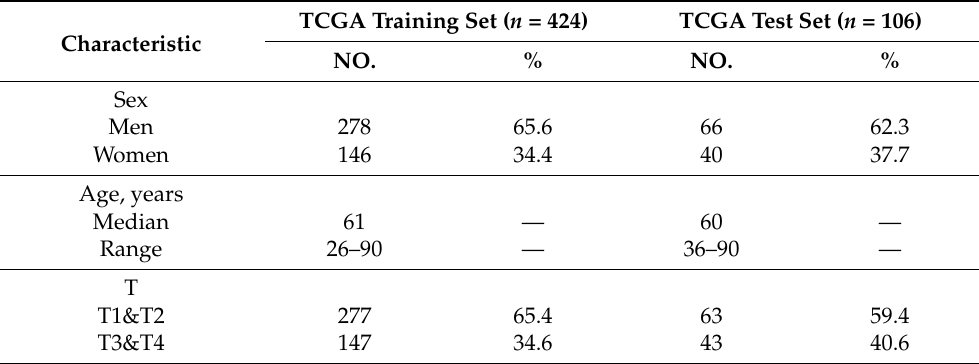
Table 1. Clinical characteristics of KIRC